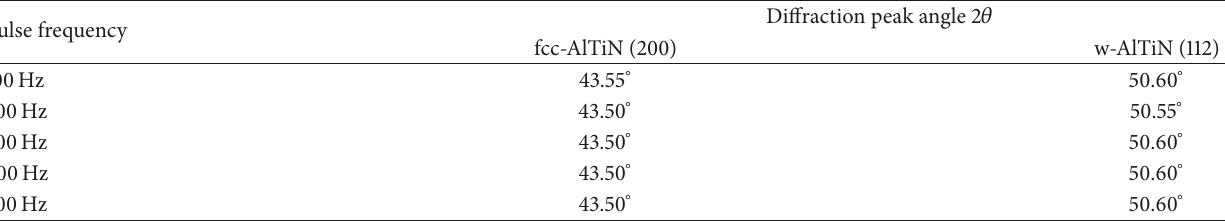
Table 3: Identified 2 𝜃 -position from the peak intensity of fcc-AlTiN phases and w-AlTiN phases at various pulse frequencies in the range of 100–500